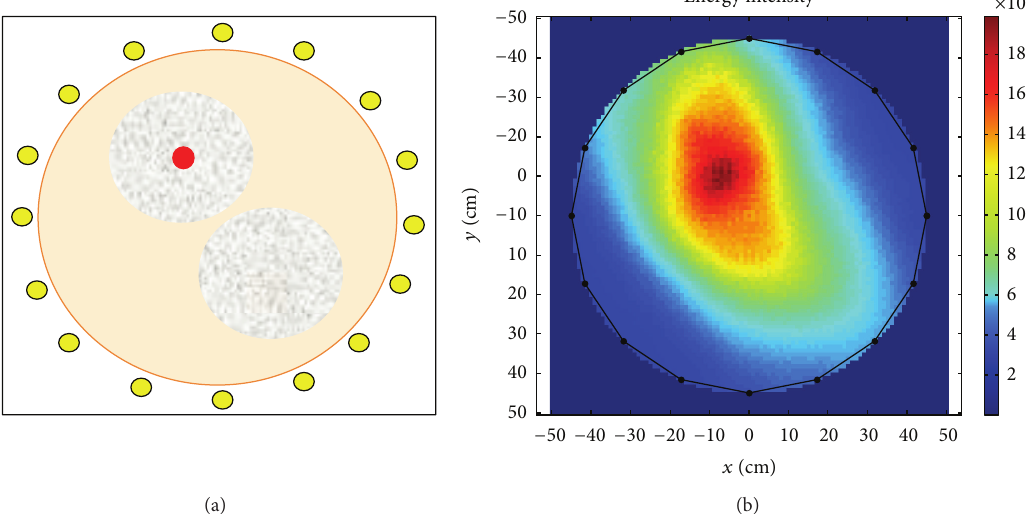
Figure 14: Image reconstruction of the heterogeneously dense breast phantom. (a) Actual image. (b) Image reconstructed using